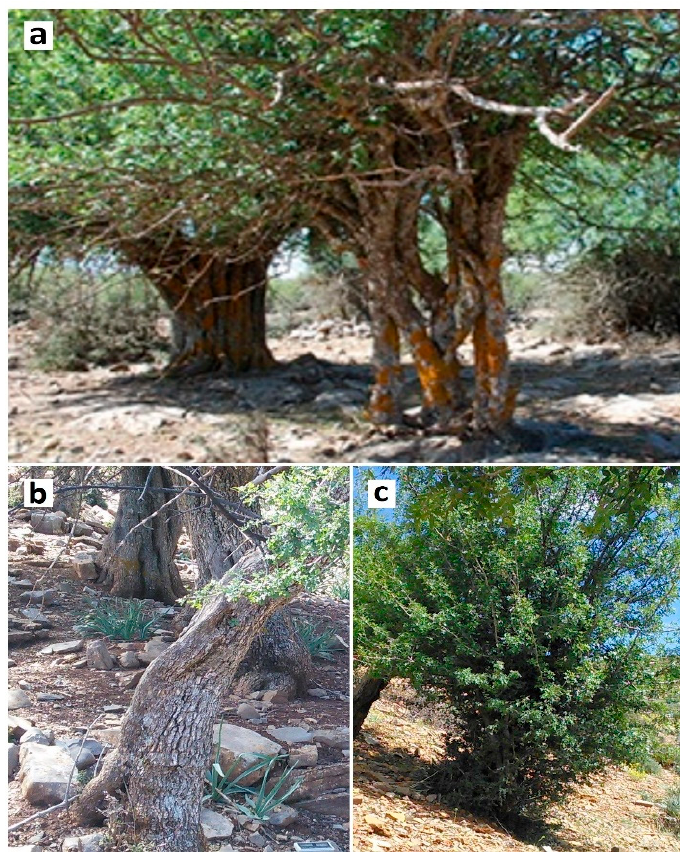
Figure 1. Four different F. dimorpha morphotypes: ( a ) anastomosed (background) and multistemmed Figure 1. Four di ff erent F. dimorpha morphotypes: ( a ) anastomosed (background) and multistemmed (foreground) (image © Genin), ( b ) single-stemmed, ( c ) shrublike (images © Fakhech). (foreground) (image © Genin), ( b ) single-stemmed, ( c ) shrublike (images ©